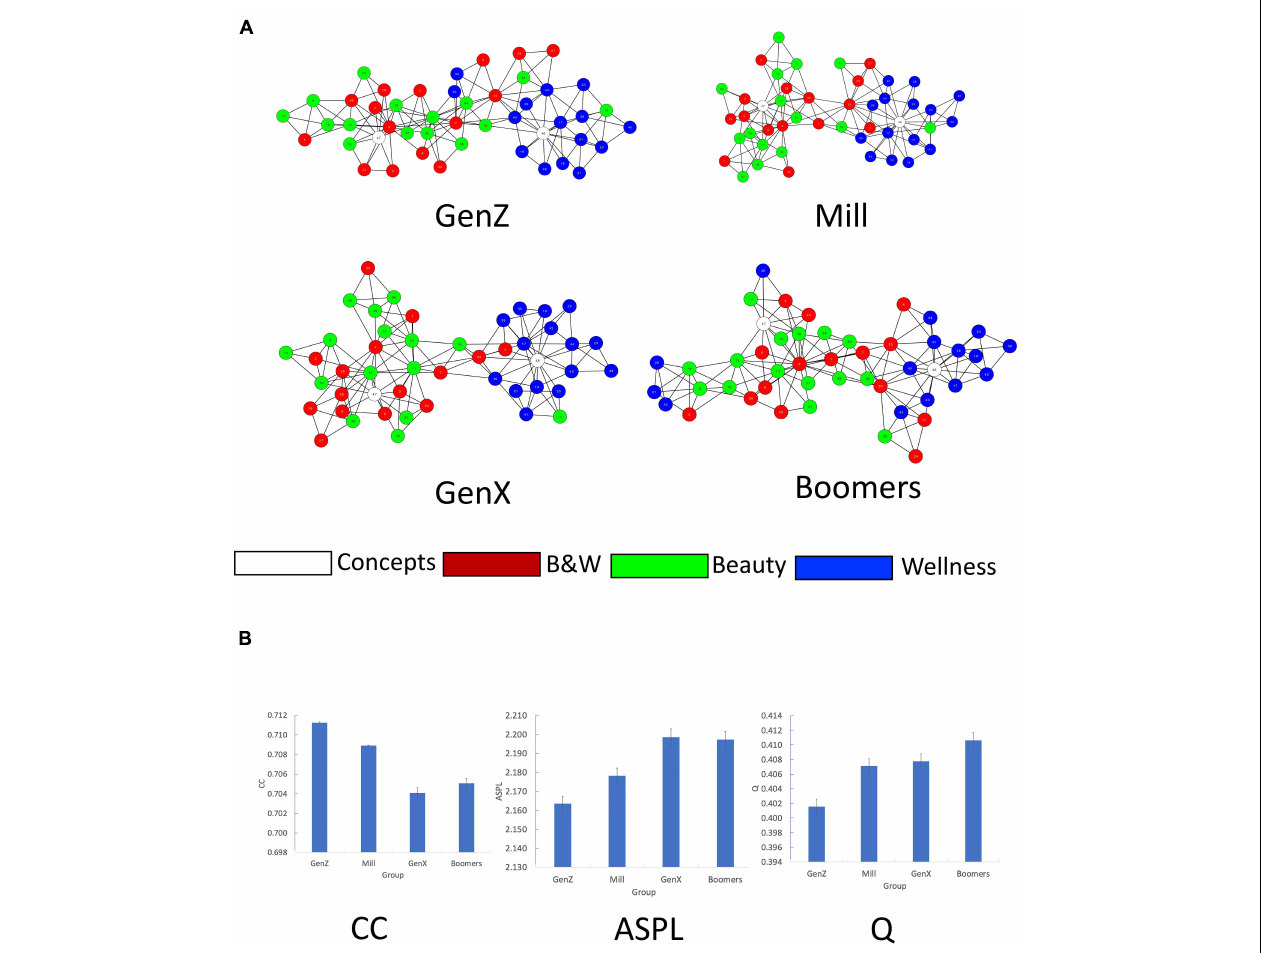
FIGURE 2 | Network analysis for Age Generation. (A) 2D visualization of the Age Generation 47 cue words (nodes) semantic networks. Edges denote symmetrical, binary relations between nodes. Colors represent category membership. Node numbers correspond to their word labels that appear in Appendix Table A1 . (B) Bootstrapping analysis of CC, ASPL, and Q for the Age Generation groups. X -axes–Group, Y = axes–network measure (CC, ASPL, and Q) values.